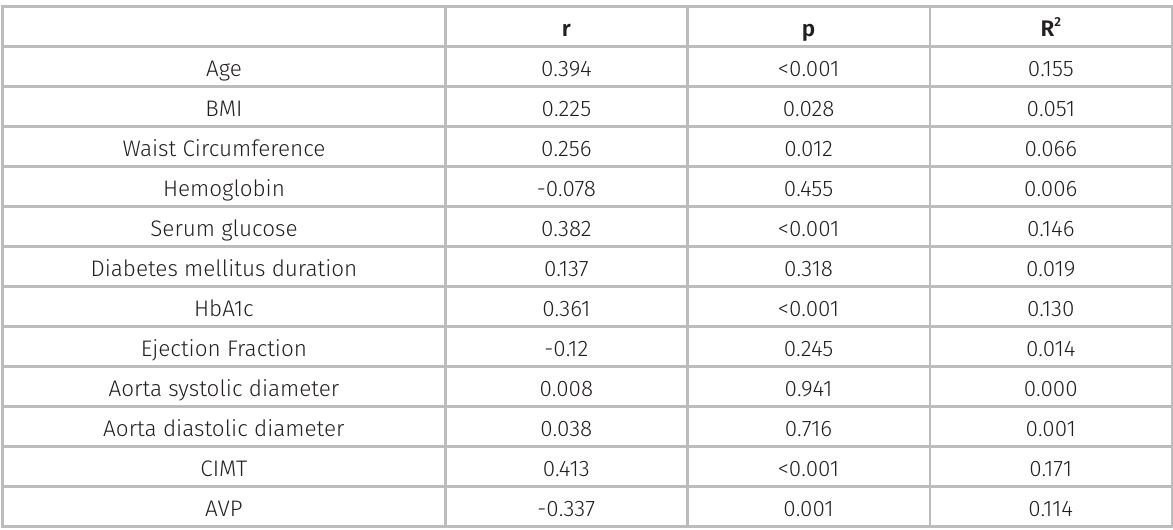
BMI, Body mass index; HbA1c, Glycolized hemoglobin; CIMT, carotid intima-media thickness; AVP, Aortic velocity propagation. Pearson test was used to analyze the relationship between EFT and study variables where appropriate. correlation coefficient (r). p<0.05 was considered statistically significant.